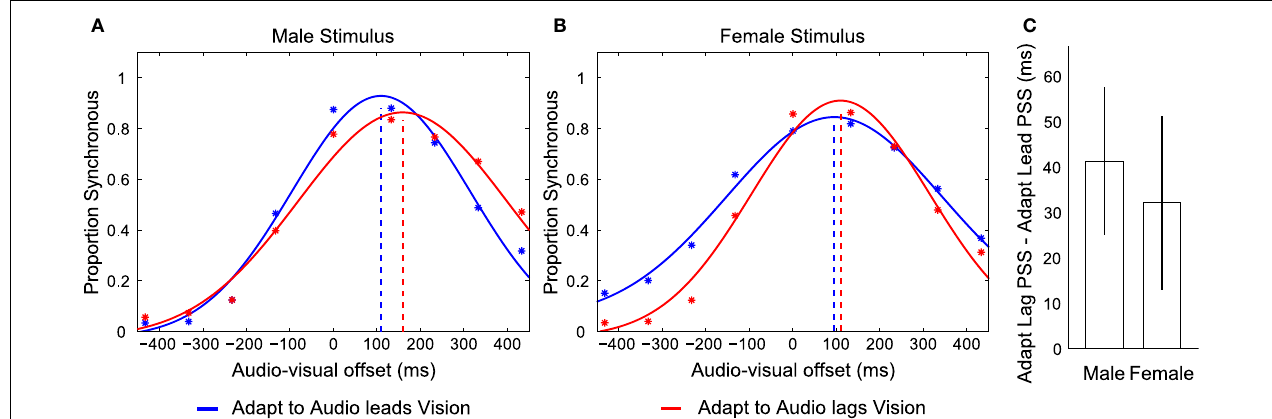
Adapt to Audio lagsVision refers to the reverse case, where the exposed timing relationship during adaptation was such that audition was presented following vision by 300ms. Note that participants concurrently adapted to opposite audio-visual timing relationships for each stimulus during a given set of trials such that they adapted to audio leads vision for the Male stimulus while concurrently adapting to audio lags vision for the Female stimulus, or vice versa. (C) Difference in PSS between adapting to an audio leading vision compared to audio lagging vision relationship for each stimulus, for each participant, averaged across the eight participants. Error bars indicate ± 1